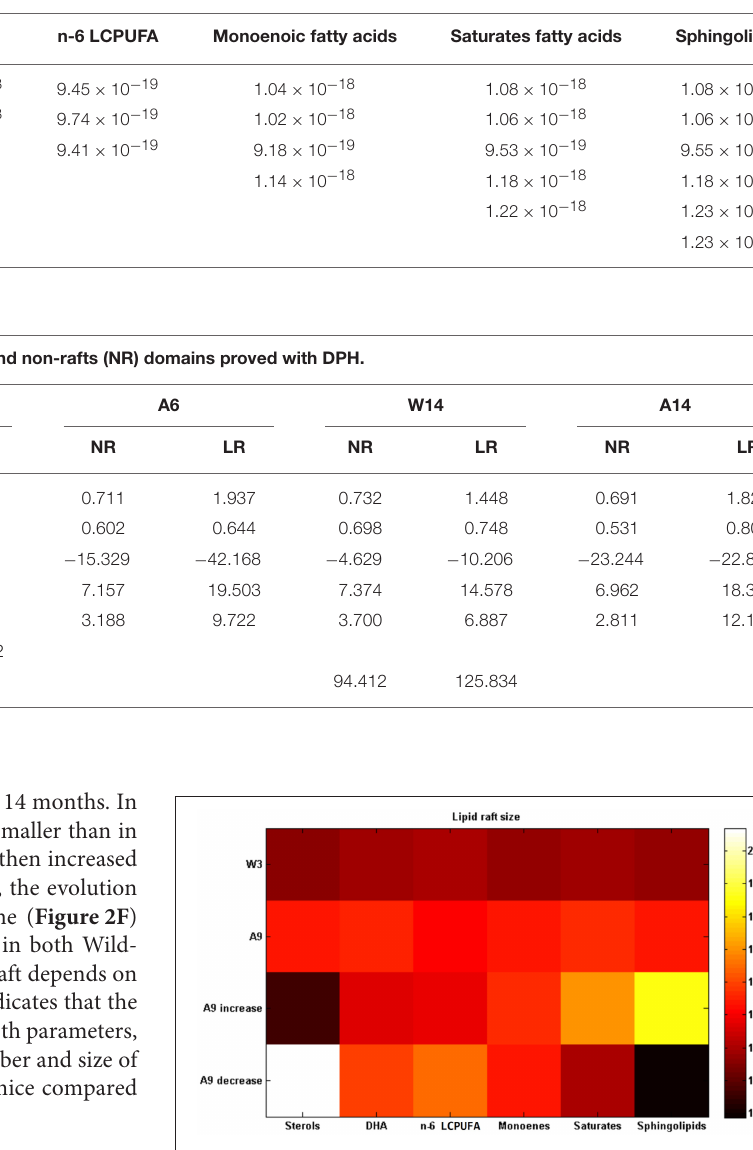
TABLE 3 | Pairs mean force interactions amongst the different lipid groups measured in Newtons (N).